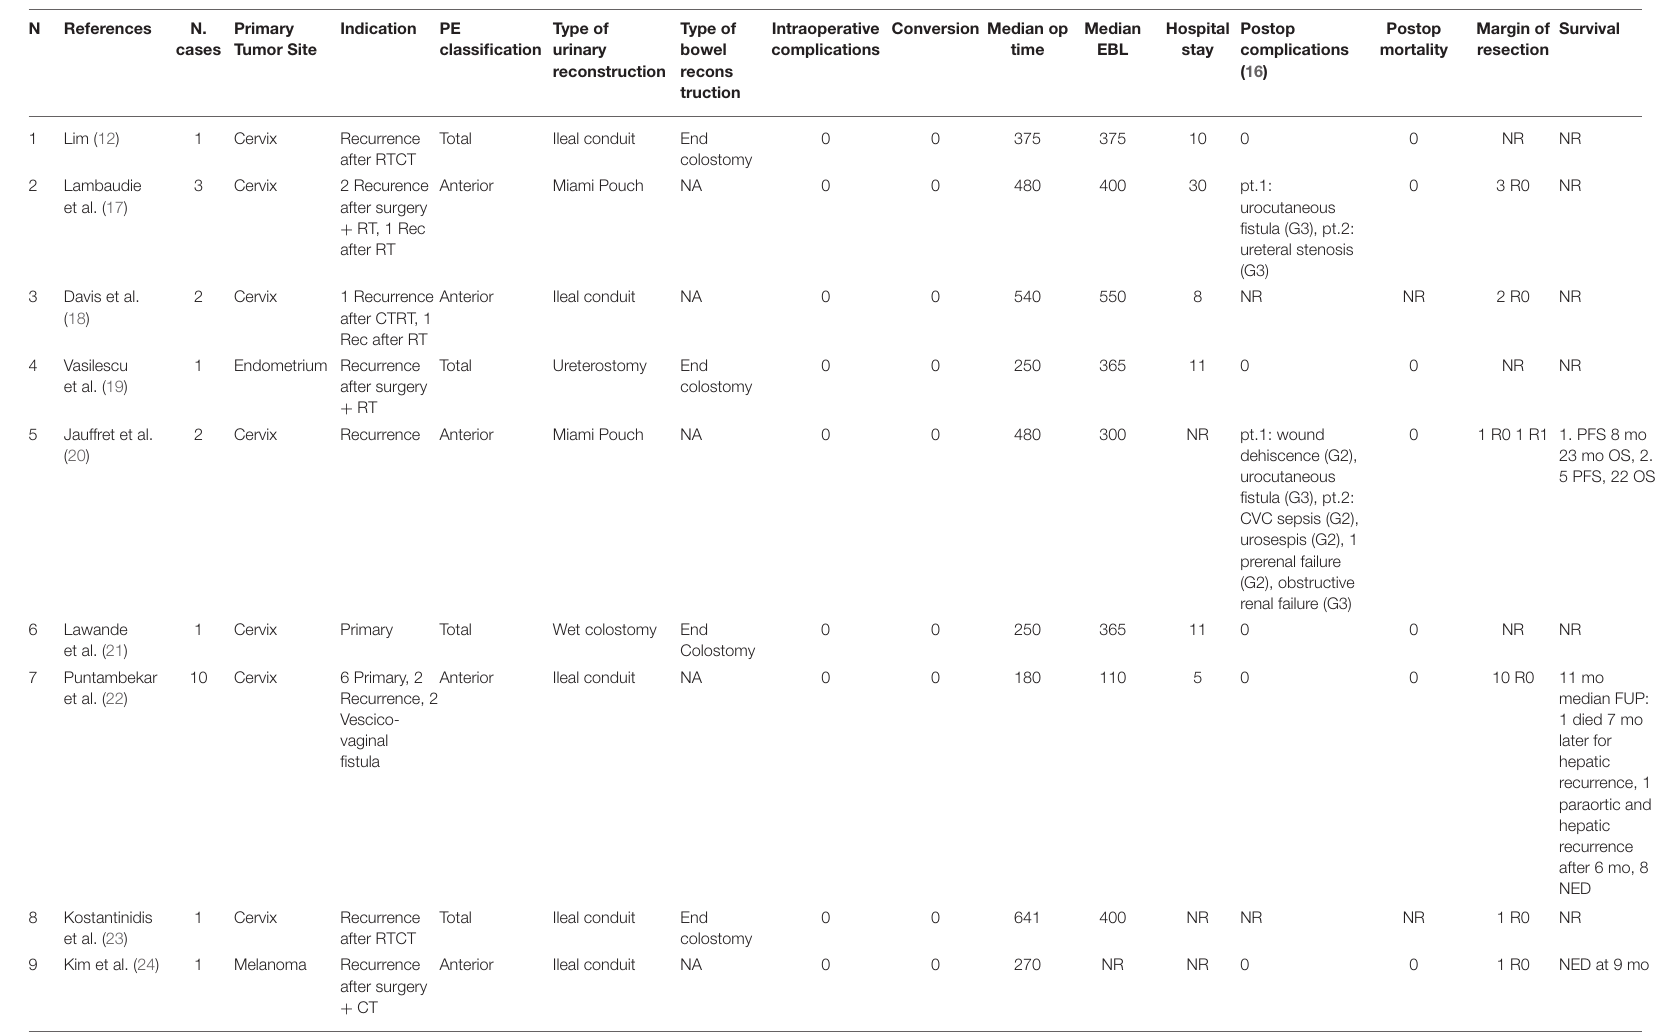
TABLE 1 | General characteristics of the included